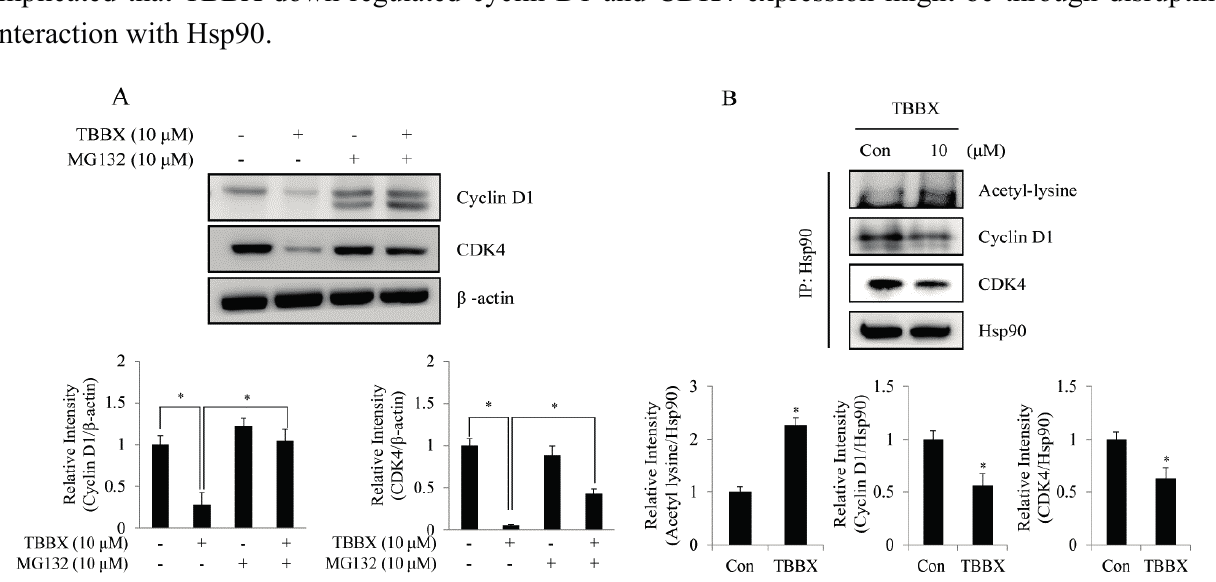
Figure 6. TBBX induced Hsp90 hyper-acetylation and disrupted cyclin D1/Hsp90 and CDK4/Hsp90 interaction and leading to cyclin D1 and CDK4 degradation in H1299 lung cancer cells . ( A ) H1299 cells were incubated with or without 10 μ M MG132 for 30 min before 10 μ M TBBX stimulation for 24 h. Cells were harvested to detect cyclin D1 and CDK4 expression by Western blotting analyses. ( B ) H1299 cells were incubated with 10 μ M TBBX for 24 h. Cells were then harvested and immuno-precipitation analysis was